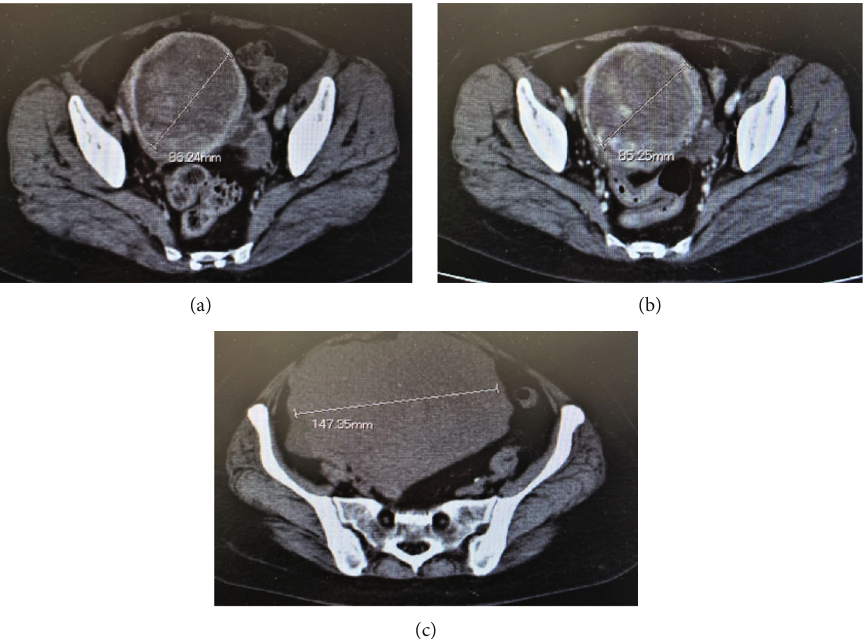
Figure 1: Preoperative pelvic CT fi ndings: (a) 1 year and 6 months after initiation of treatment: myoma fi broids were noted; (b) 1 year and 10 months after initiation of treatment: the patient experienced abdominal pains, and imaging diagnosis demonstrated an infection of a degenerated myoma uteri fi broid; (c) 2 years after initiation of treatment: elevated serum D-dimer and LDH were noted, and imaging diagnosis noted a di ff erential diagnosis of uterine sarcoma or uterine metastasis from lung